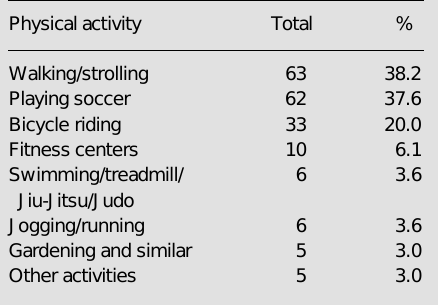
Table 6 - Data about the physical activities of the drivers (N = 400).